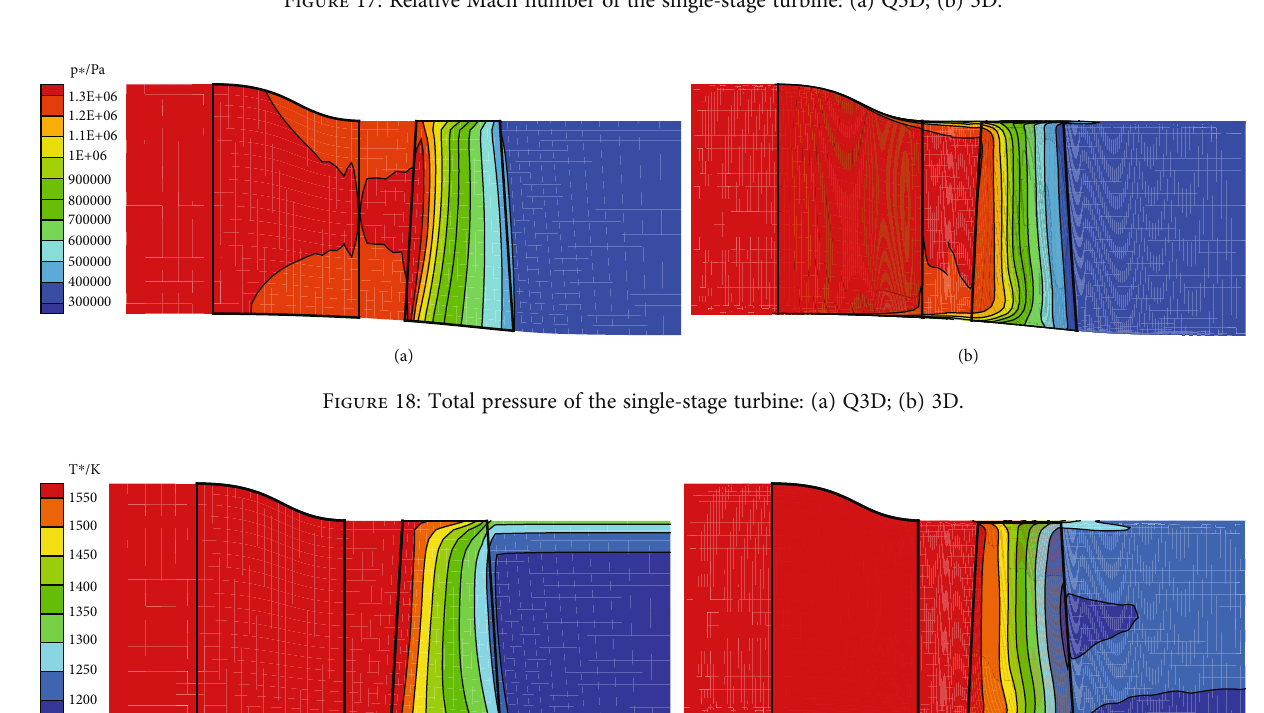
Figure 17: Relative Mach number of the single-stage turbine: (a) Q3D; (b) 3D.